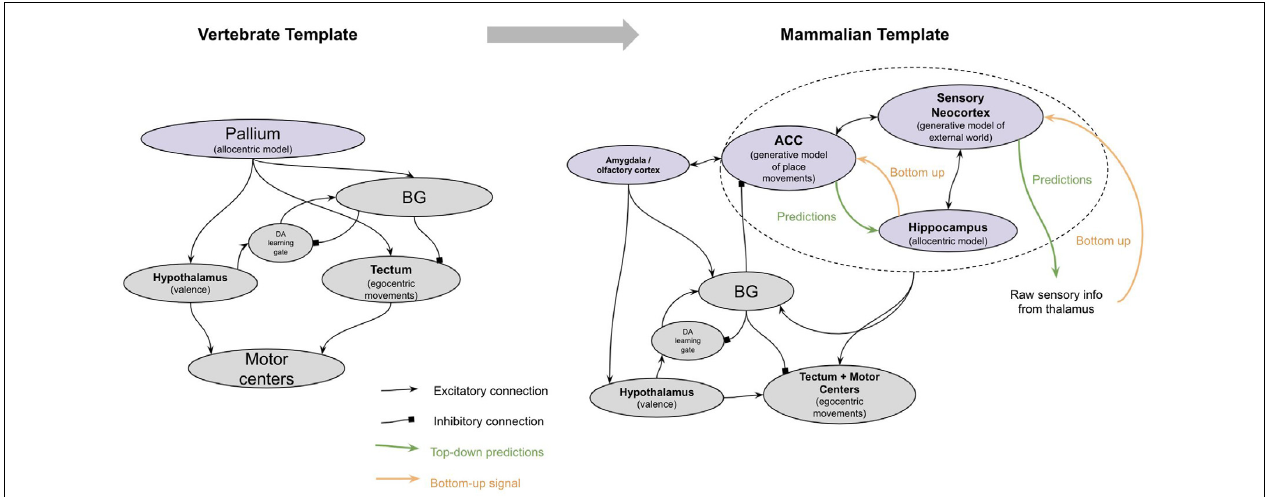
FIGURE 4 | The major brain modifications in early